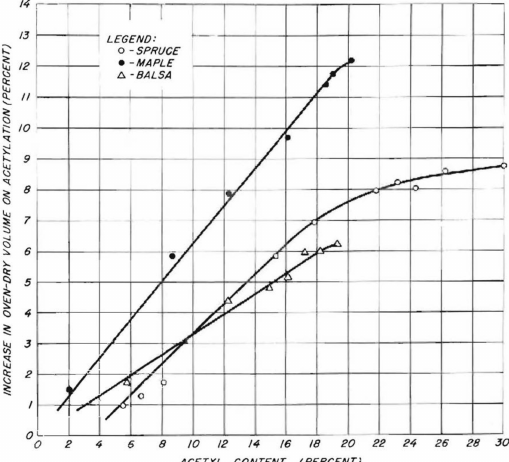
Figure 3. Relationship between the acetyl and the percentage increase in oven-dry volume [7].